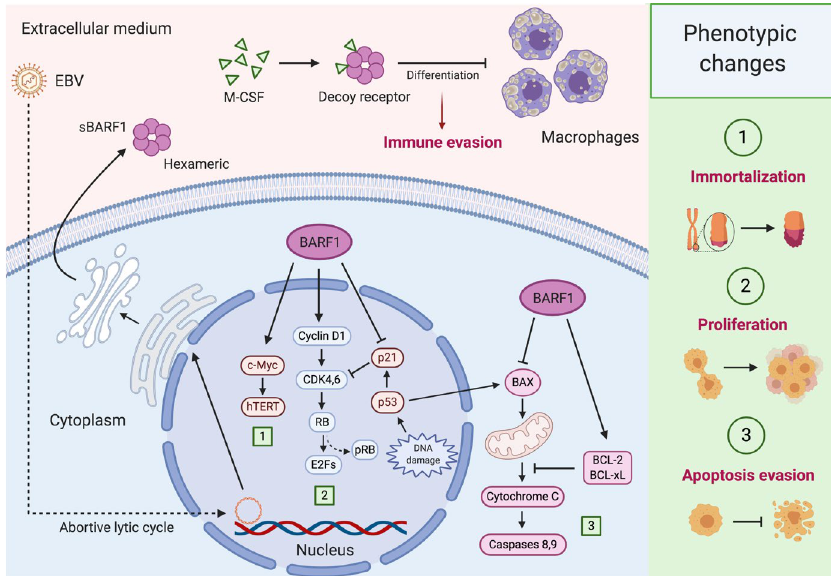
Figure 2. BARF1-mediated carcinogenesis in epithelial cells. During epithelial Epstein–Barr virus (EBV) latency (I / II), some lytic genes such as BARF1 are expressed (abortive lytic infection), cooperating with latent genes for carcinogenesis. (1) BARF1 synergizes with c-Myc to promote hTERT activation, avoiding replicative senescence and leading to epithelial cell immortalization; (2) BARF1 also increases cyclin D1 levels promoting the progression from G1 to S-phase of the cell cycle. Moreover, BARF1 induces a reduction in p21 WAF1 levels disrupting one of the most important regulatory mechanisms of cell proliferation; (3) BARF1 rescues epithelial cells from apoptosis reducing the expression of the pro-apoptotic Bax and increasing the anti-apoptotic proteins Bcl-2 and Bcl-xL. Furthermore, BARF1 is secreted as a hexameric protein (sBARF1) which contributes to